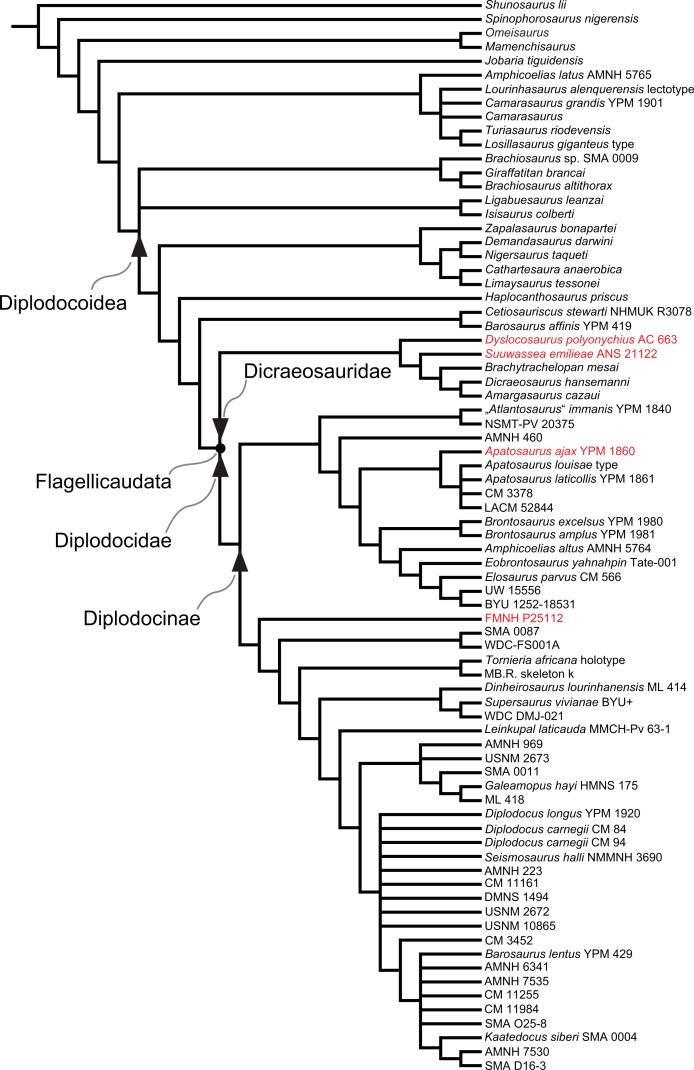
Pruned strict consensus tree obtained by equal weighting.The following OTUs were pruned a posteriori: ‘Apatosaurus’ minimus AMNH 675, ‘Diplodocus’ lacustris YPM 1922, Dystrophaeus viaemalae USNM 2364, and the type individual of Australodocus bohetii. Note the dicraeosaurid affinities of Dyslocosaurus and Suuwassea, the inclusion in Diplodocinae of FMNH P25112, and the close association of Apatosaurus ajax with Apatosaurus louisae (in red).